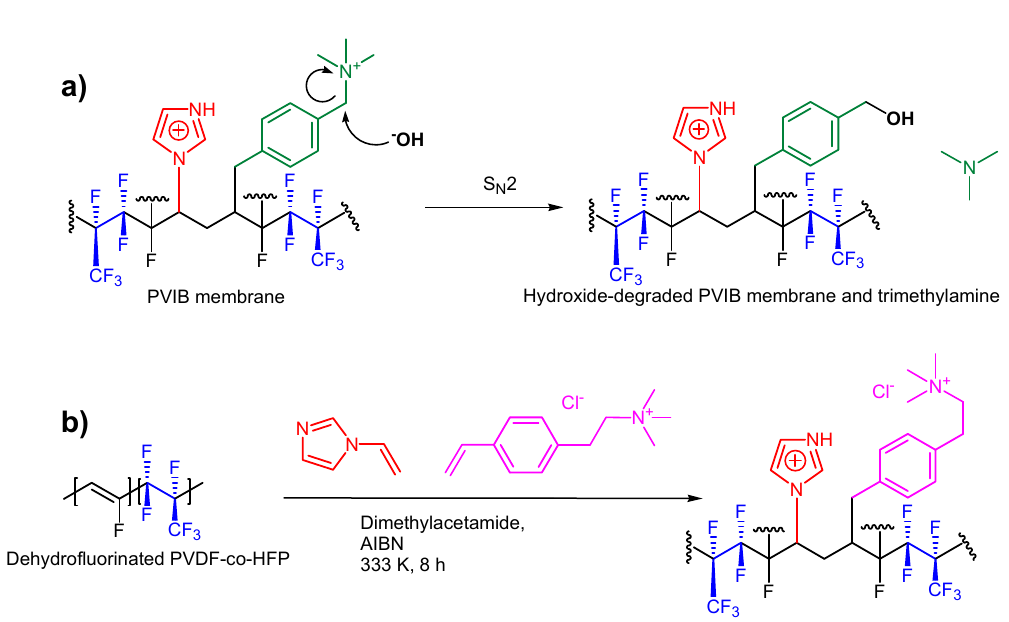
Figure 11. ( a ) A possible hydroxide-meditated route to membrane degradation involving the cleavage of trimethylamine from the polymer. ( b ) A potential strategy for the synthesis of a more stable analogue of PVIB: The vinylbenzene derivative highlighted in pink replaces (vinylbenzyl) trimethylammonium chloride in the general synthetic scheme shown in Figure 2, with the extra methylene group disfavouring the facile S N 2 mechanism shown in panel ( a ).